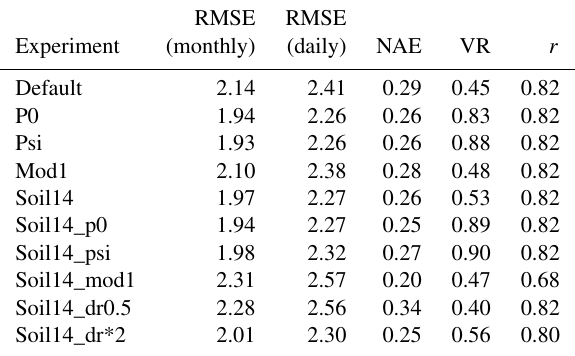
Table 5. Average results of soil moisture stress experiments for GPP at the soil-moisture-stressed sites GF-Guy, BE-Vie, DE-Tha, and CA-Oas.